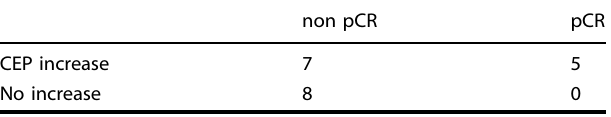
Table 2. CEP increases and pathological